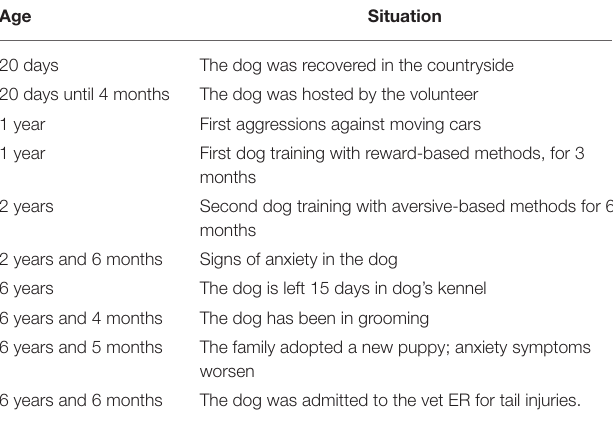
TABLE 1 | Correlation between the dog’s age and situations during the dog’s